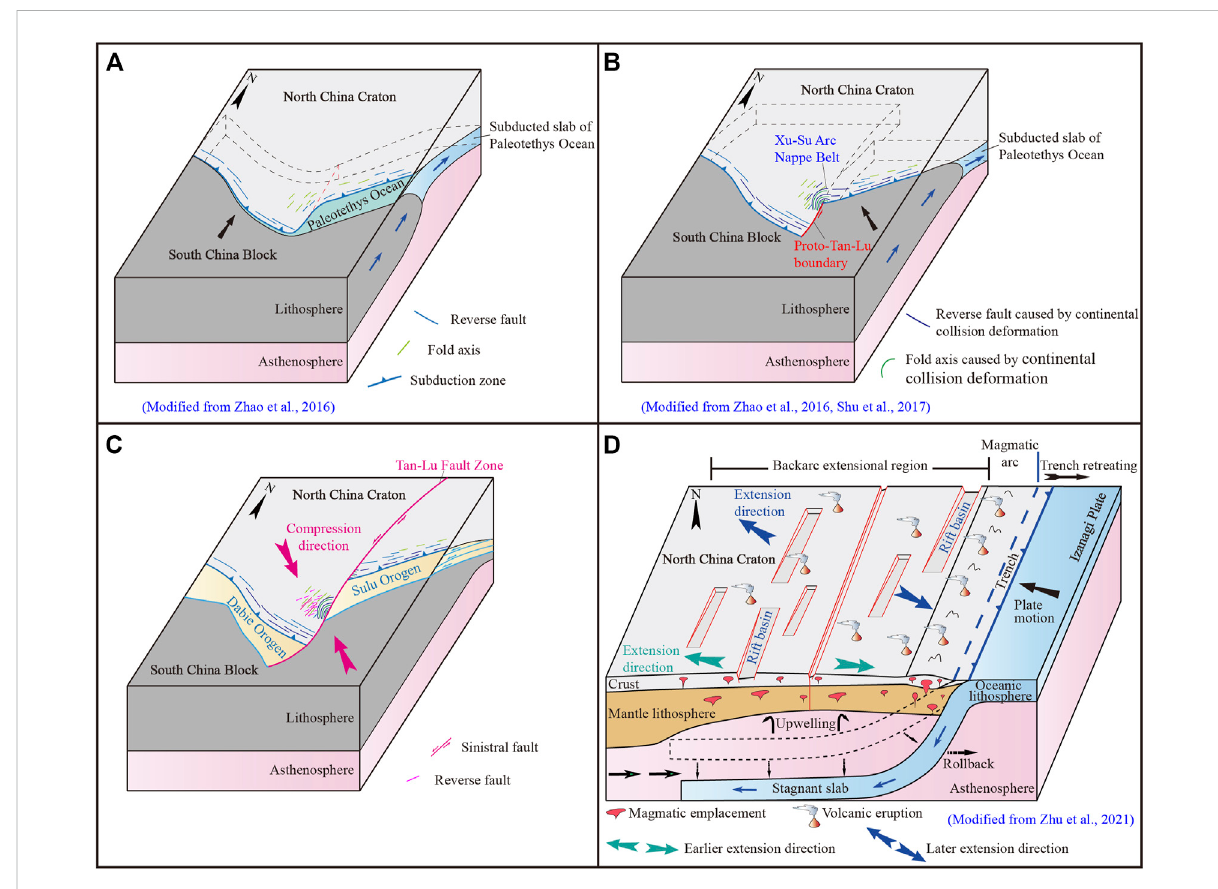
FIGURE 5 Schematic Mesozoic geodynamic evolution model of the Huaibei Coal fi eld. (A) In the fi rst stage, a series of NNE-trending gentle asymmetrical folds were developed in the Huaibei Coal fi eld due to foreland shortening deformation during the subduction of the Paleotethys Ocean. (B) In the second stage, the Xu-Su Arc Nappe Belt as well as the nearly N ‒ S-striking reverse faults in the Qianyingzi Coal Mine were formed in the intense westward compressive stress generated by the corner collision of the Sulu Orogen during the Indosinian Movement. (C) In the third stage, the NE-SW – striking reverse and nearly N-S – striking sinistral faults were developed under a NW ‒ SE compressive stress regime in response to the subduction of the Izanagi Plate during the earliest Early Cretaceous. (D) Backarc extension under slab rollback of the Izanagi Plate resulting in nearly E ‒ WextensionofthefourthstageandNW-SEextensionofthe fi fthstagesuccessively,regionallyaccompaniedbyintensemagmaticactivityandthe development of widespread rift